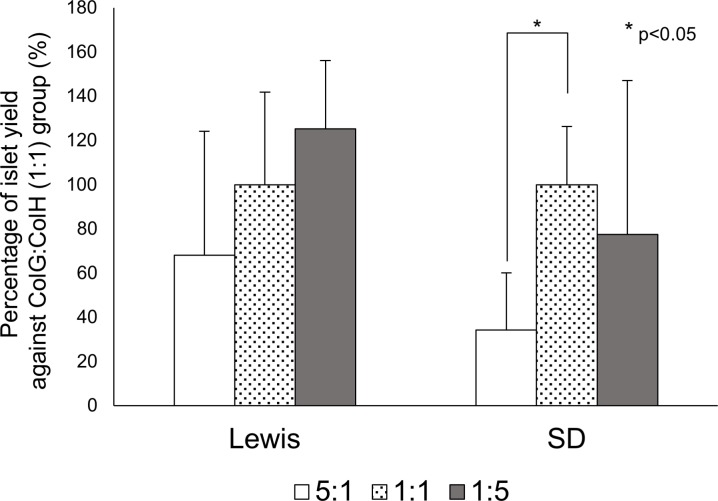
Effects of the ColG:ColH ratio on the islet yield for each rat strain.The islet yields of the 5:1 (white) and 1:5 (gray) groups are presented as the percentage when the yield of the 1:1 group (dotted) was considered 100% in each strain.